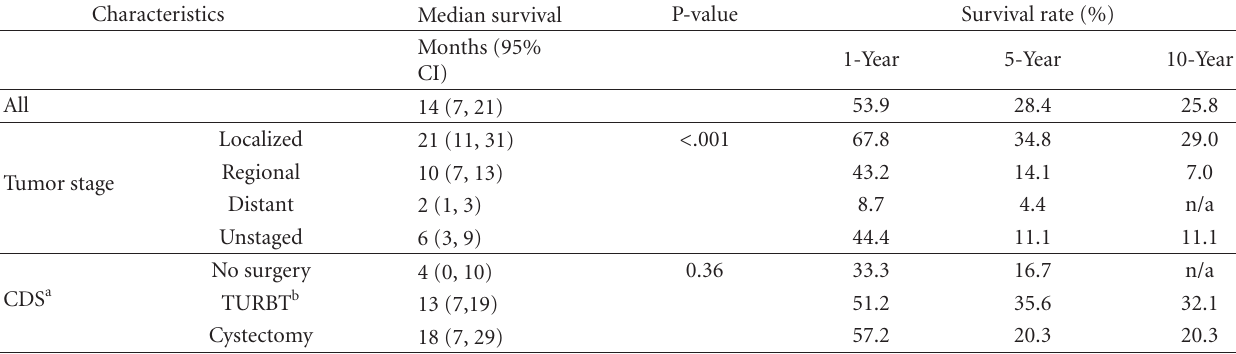
Table 3: Median, 1-, 5-, and 10-year cancer specific survival of patients with sarcomatoid carcinoma (carcinosarcoma) of the urinary bladder according to demographic and clinical characteristics.